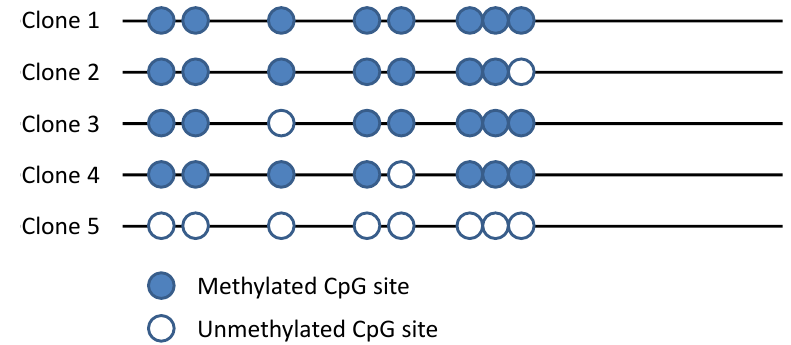
Figure 4. Typical presentation of the results for DNA methylation after bisulfite sequencing. The PCR product is cloned, and several randomly-selected plasmids are